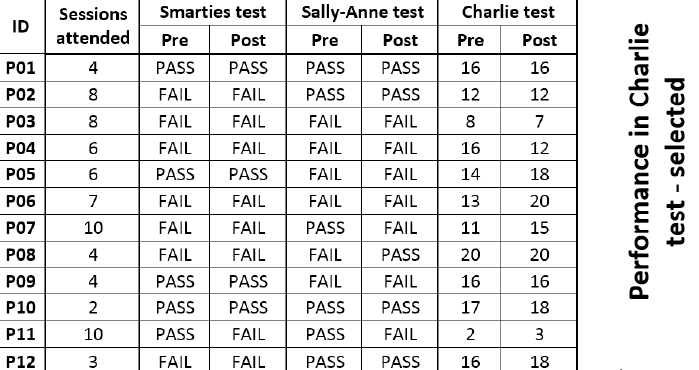
Figure 13: Pre- and post-assessment sessions of 7